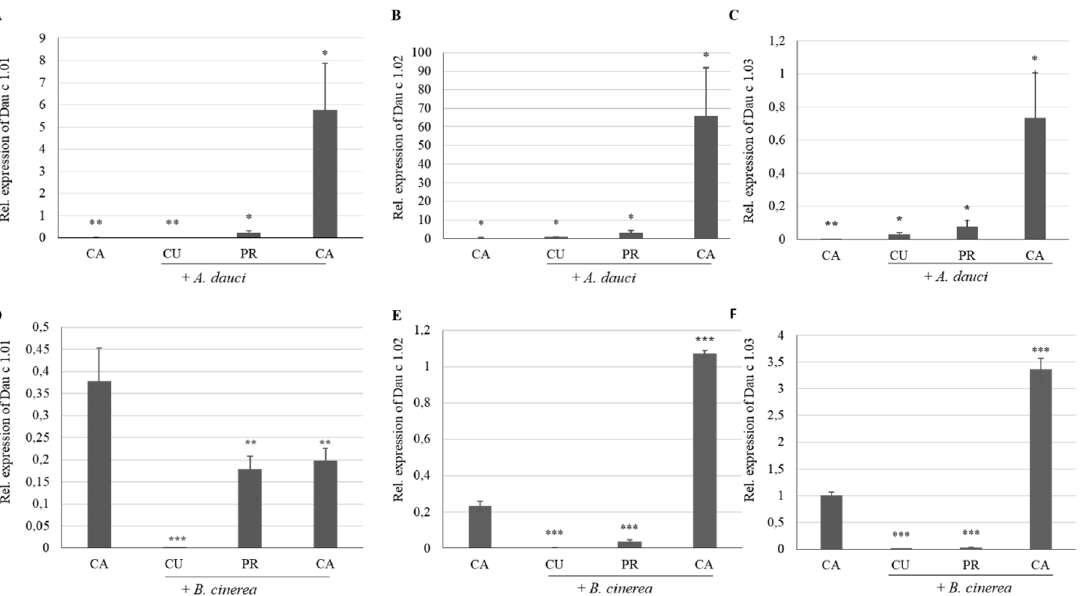
Figure 5. Quantification of PR 10 gene expression in carrot sprayed with fungal conidia. The relative expression of three different carrot PR 10 genes (syn. Dau c 1.01; Dau c 1.02 and Dau c 1.03 ) was quantified with qPCR and normalized with carrot ubiquitin . ( A – C ) Plants sprayed with Alternaria dauci conidia . ( D – F ) Plants sprayed with Botrytis cinerea conidia. Bars represent standard deviation of three replicates and significant changes are marked: * p < 0.05; ** p < 0.01; *** p < 0.001 (Student’s t -test. PR = preventive; CU = curative; CA = control non-treated.